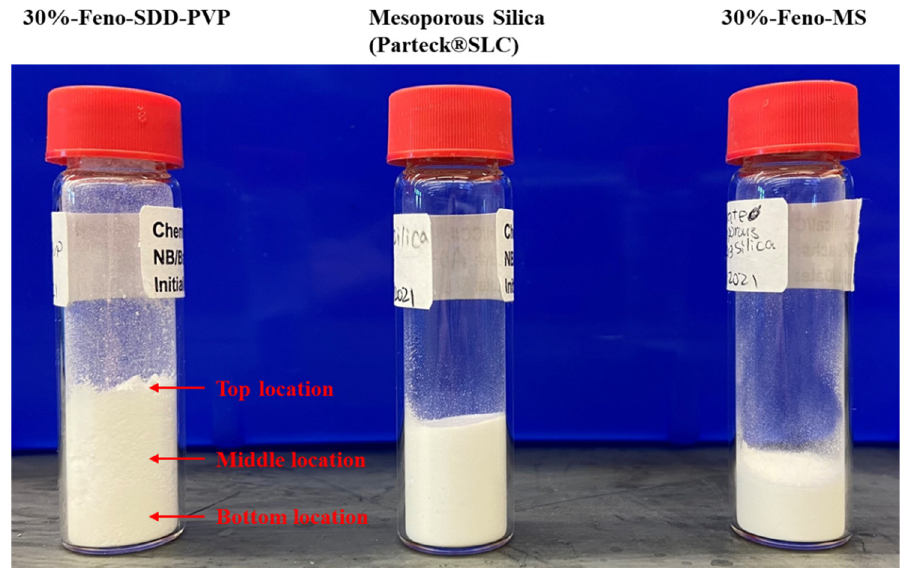
Figure 6. Pictures of 30%-Feno-SDD-PVP (left), mesoporous silica (Parteck ® SLC, middle), and 30%-Feno-MS (right). Three samples were pulled out from top, middle, and bottom locations for assay and impurity tests of Feno-SDD and Feno-MS samples.